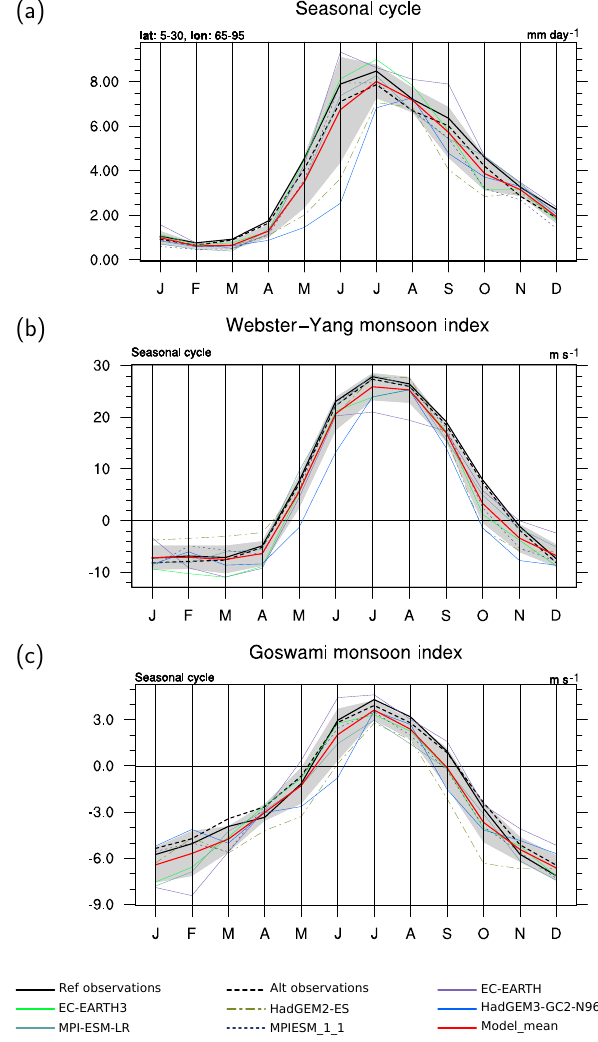
Figure 6. Mean annual cycle plots averaged over the years 1986– 2005 (HadGEM: 1986–2004): (a) precipitation spatially averaged over 5–30 ◦ N, 65–95 ◦ E, (b) Webster and Yang monsoon index, (c) Goswami monsoon index. Shown are the coupled (histori- cal) simulations. The reference observations (a) TRMM-L3 and (b, c) ERA-Interim are shown as solid black lines, the alternative observations (a) GPCP-SG and (b, c) NCEP 1 as black dashed